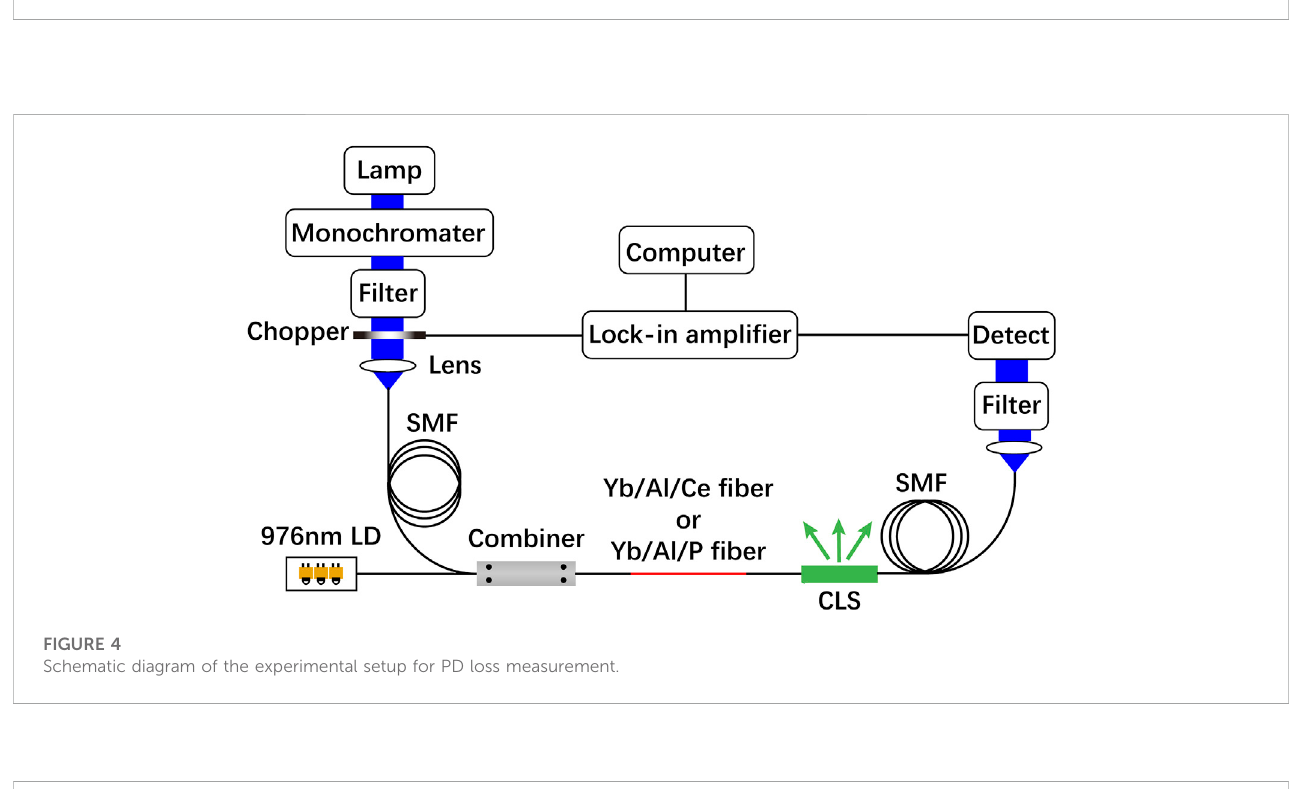
FIGURE 3 (A) Thebendlossesand (B) theeffectivemodeareasasthefunctionsofthedifferentbendradiuses.Simulationparameters:core/innercladdingdiameter of 20/400 μ m, NA of 0.06 and center wavelength of 1,080 nm.